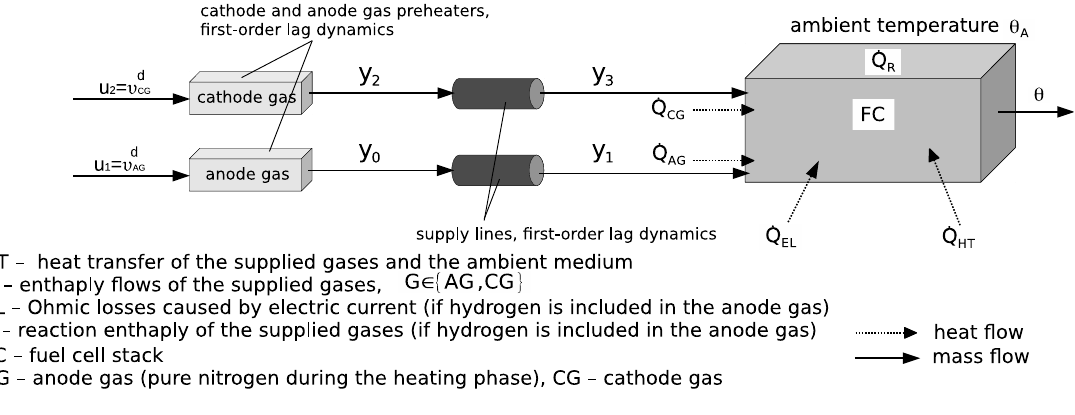
Figure 1. Schematic visualization of the thermal subsystem of the SOFC stack with